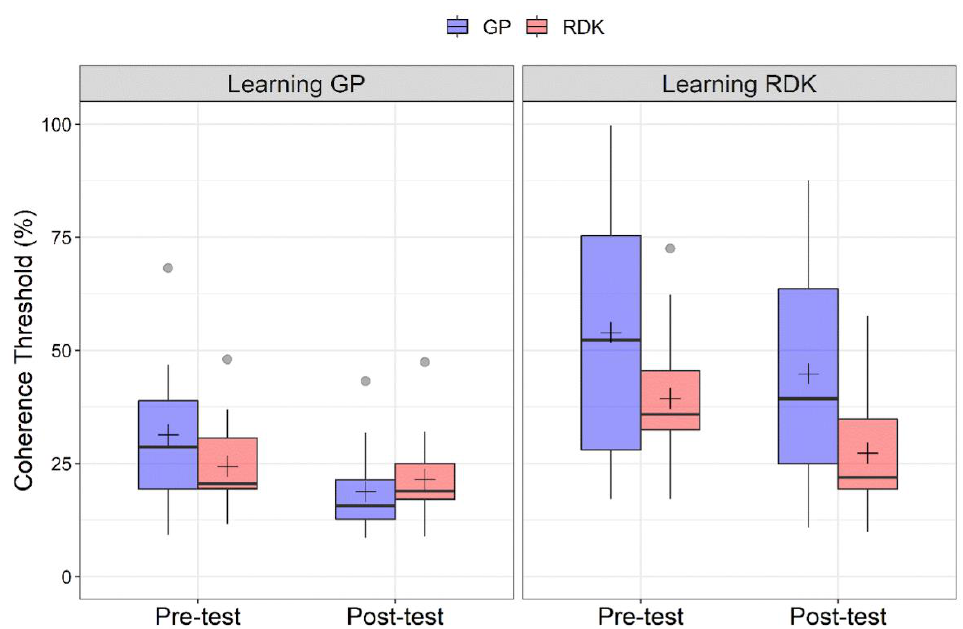
Figure 2. Boxplots of coherence thresholds (%) for the two types of training. (Left panel) Coherence thresholds for pre- and post-tests relative to the learning Glass pattern (GP) group, for GPs and random dot kinematograms (RDKs). (Right panel) Coherence thresholds for pre- and post-tests relative to the learning RDK group. For each boxplot, the horizontal black line indicates the median, whereas the black cross indicates the mean coherence threshold for that condition. Grey points indicate outliers. Data were plotted using R (v4.1.3; Boston, MA, USA). Table 1. Estimated coefficients of the best fitting generalized linear mixed model (GLMM). Standard Error (SE), t- and p-values for predictors (including intercept) are listed.